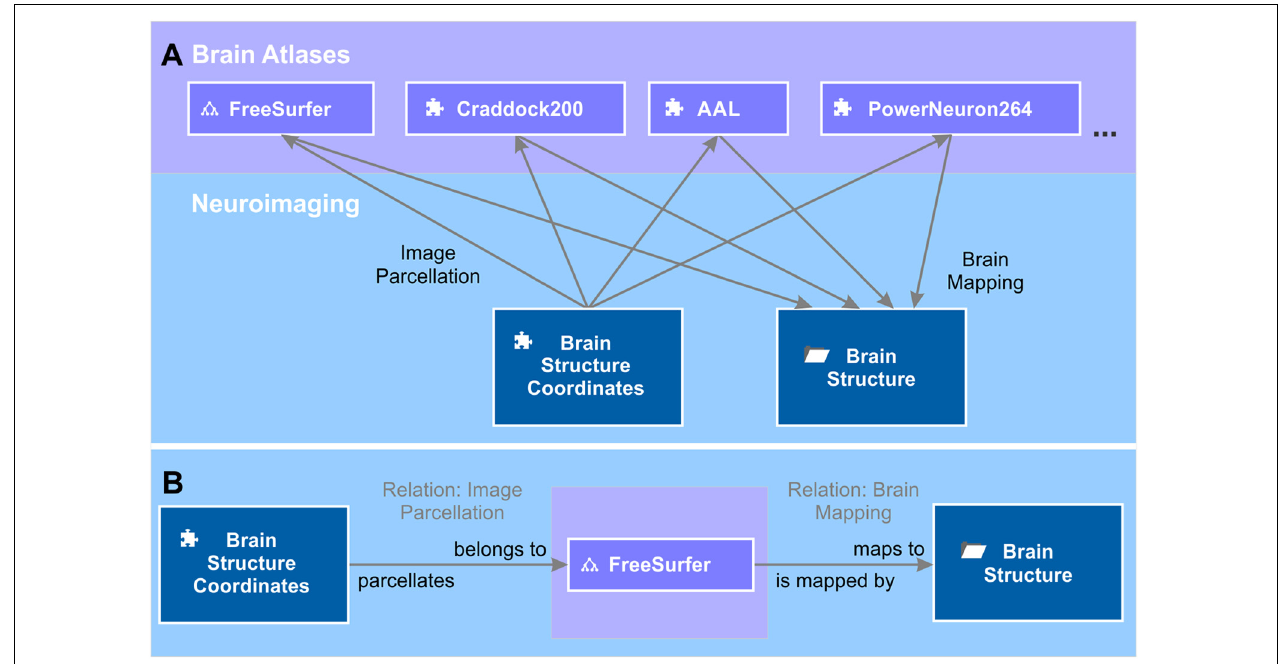
FIGURE 5 | Brain mappings. (A) Brain atlases are used to parcellate the brain image into volumes that correspond to a certain brain area. The relation between volumes and brain areas are defined by the brain atlas. The tree diagram icon and the puzzle icon indicate whether the brain atlas is an ontology or an element. Entries of the different brain atlases are mapped to a unified repository of brain structures – the context “brain structure.” The semantic object kind “context” provides the possibility of grouping semantic objects that are of relevance for this brain structure, e.g., literature references (not shown). (B) The semantic relation “image parcellation” that relates the element “brain structure coordinates” to a brain atlas, e.g., “FreeSurfer” is defined by “belongs to” and “parcellates” in forward and backward directions. Likewise, the relation “brain mapping” is defined by “maps to” and “is mapped